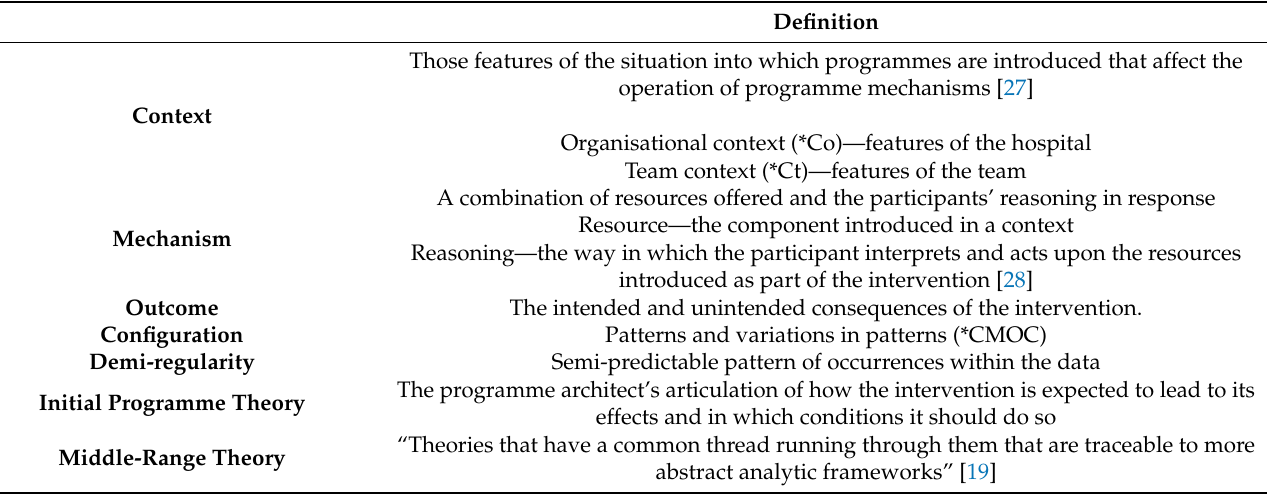
Table 1. Realist